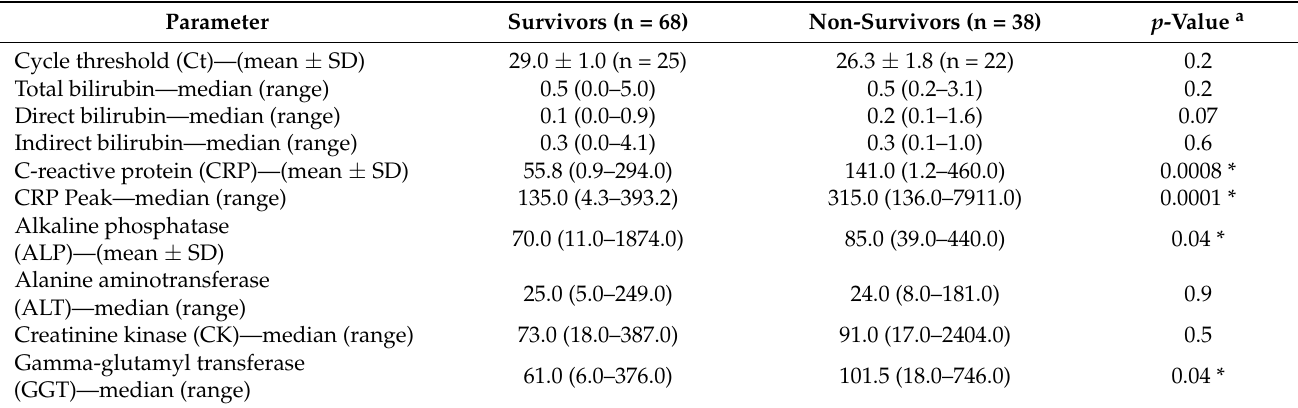
Table 4. Laboratory parameters of COVID-19 patients according to disease